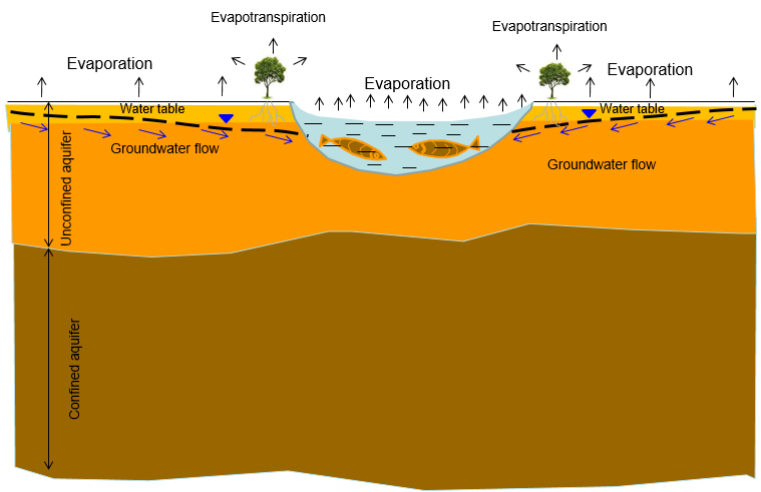
Figure 5. Conceptual representation of groundwater evaporation pond in the shallow saline environment.